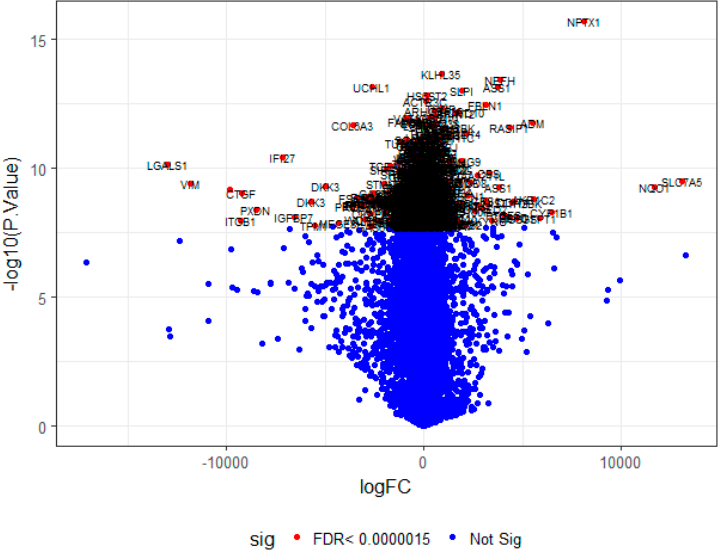
Figure 4. A volcano plot of differentially-expressed genes.